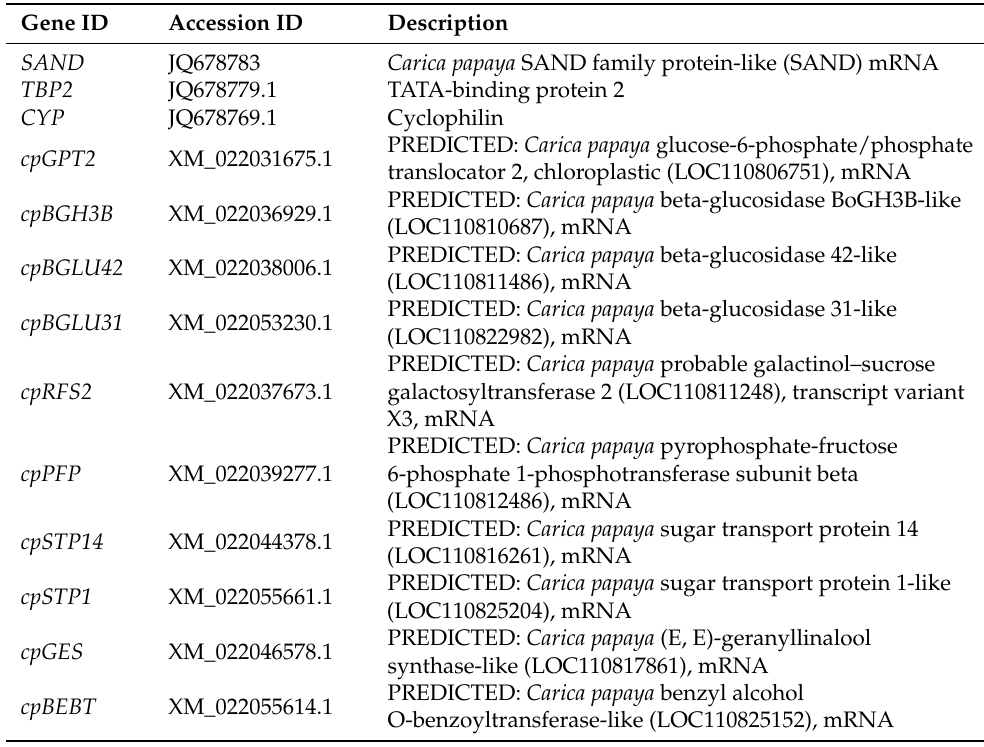
Table 6. Candidate gene list for Nanostring